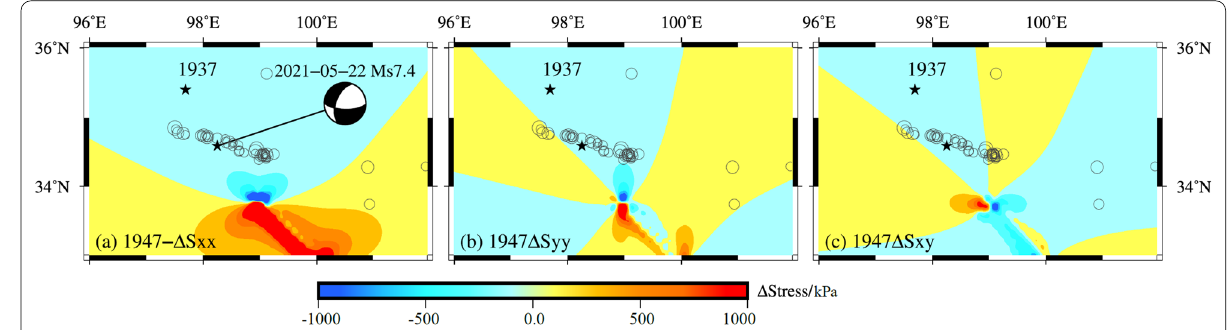
Fig. 10 Stress change induced by 1947 event with the other focal